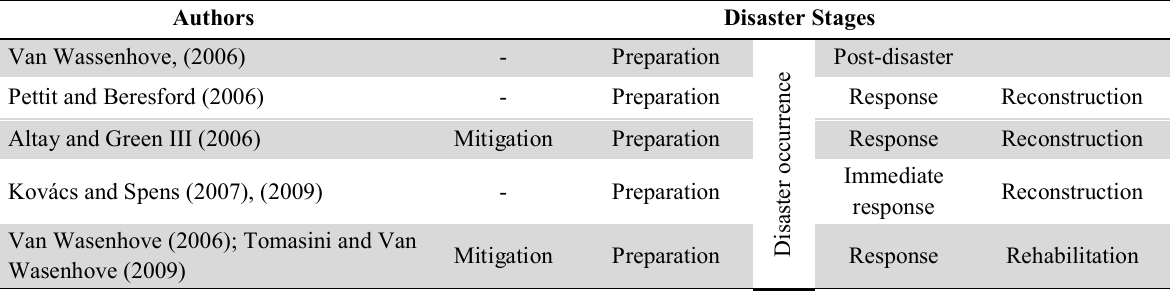
Disaster management stages according to different